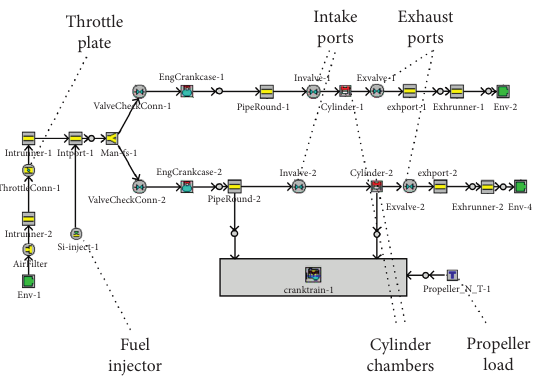
Figure 5: One-dimensional GT-Power model of the two-stroke